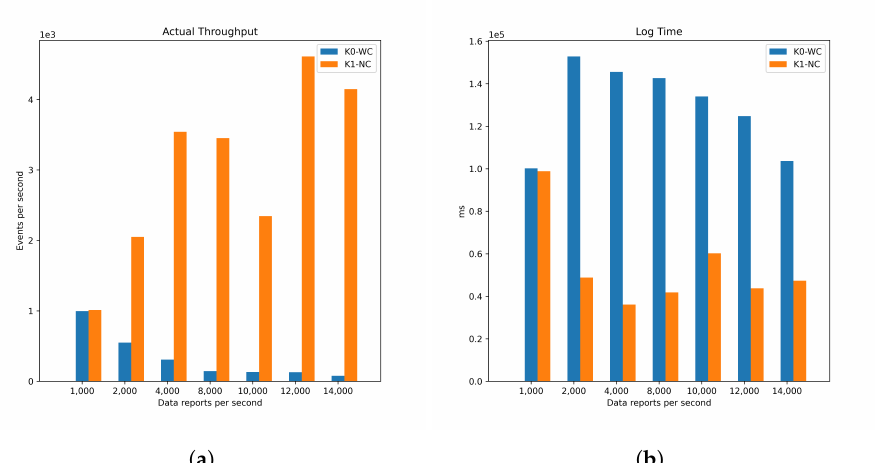
Figure 8. Implementation performance measured as throughput and log time, for each implementa- tion and Data Reports’ rate. ( a ) Actual throughput. ( b ) Log